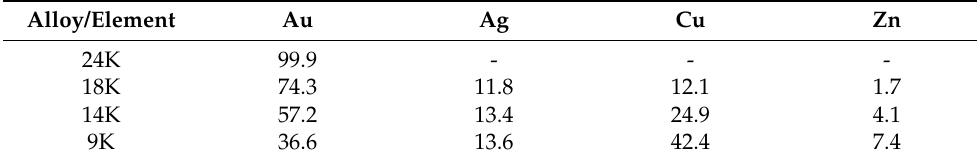
Table 2. Composition of gold and gold alloys studied (wt.%) by XRF.